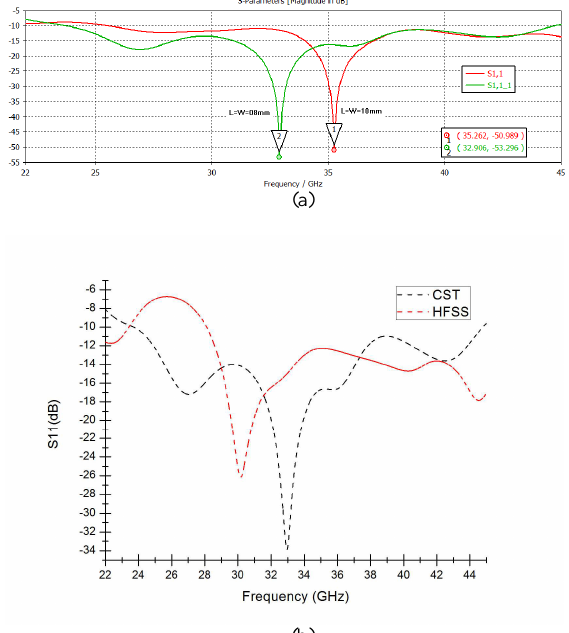
Fig4. The current distribution on the surface of the primary element antenna at 33 GHz.